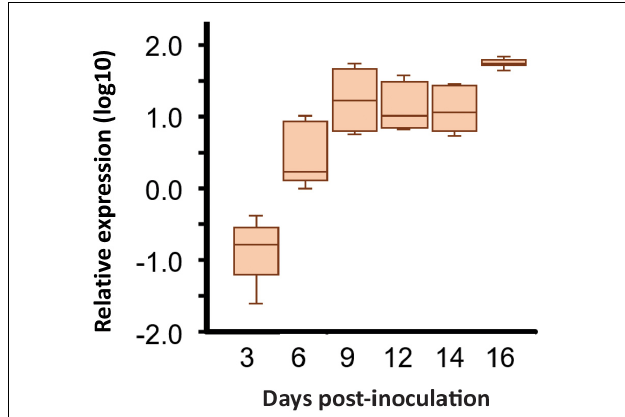
FIGURE 1 | Expression of the Cladosoprium fulvum Ecp20-2 gene is induced after infection of tomato seedlings. Expression was monitored by a quantitative real-time PCR in tomato plants inoculated with C. fulvum strain 0WU at 3-, 6-, 9-, 12-, 14-, and 16-days post-inoculation (dpi). Expression was normalized to that exhibited by the C. fulvum actin gene or tomato rubisco gene according to the 2 − (cid:49) Ct method with the average of three biological replicates. The box plot indicates the median indicated by the horizontal line in the box with the lines indicating the top and bottom 25% of the distribution, whiskers represent the maximum and minimum values, and the outliers are indicated by dots. Statistical differences among strains have been analyzed using the Tukey’s multiple comparison test.